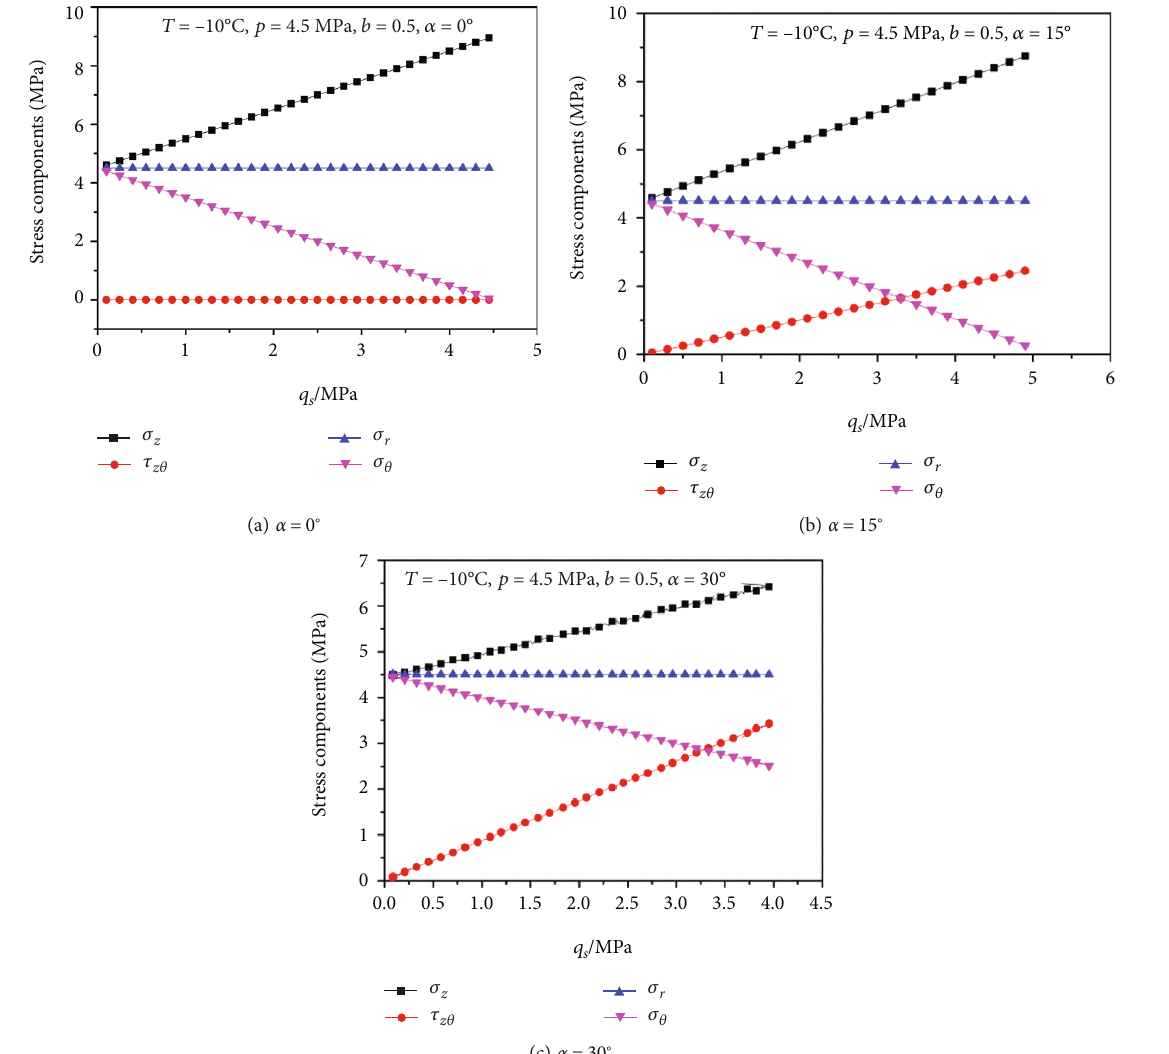
Figure 8: Relationships between shear stress and stress components of the